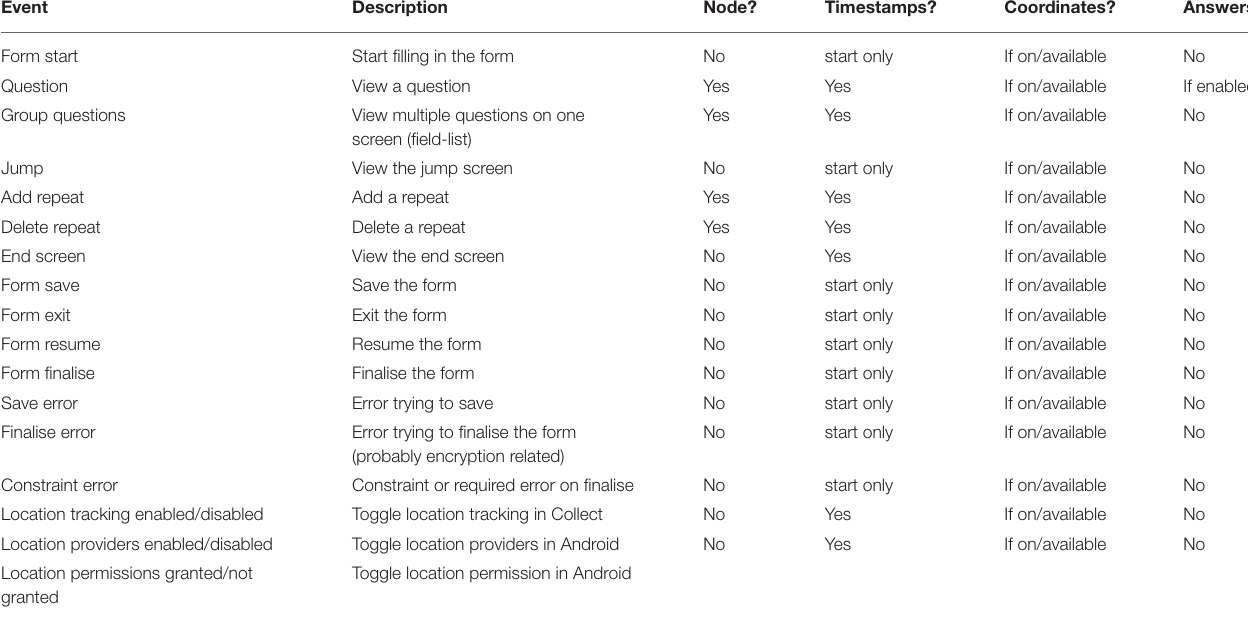
TABLE 2 | Event types in ODK audit